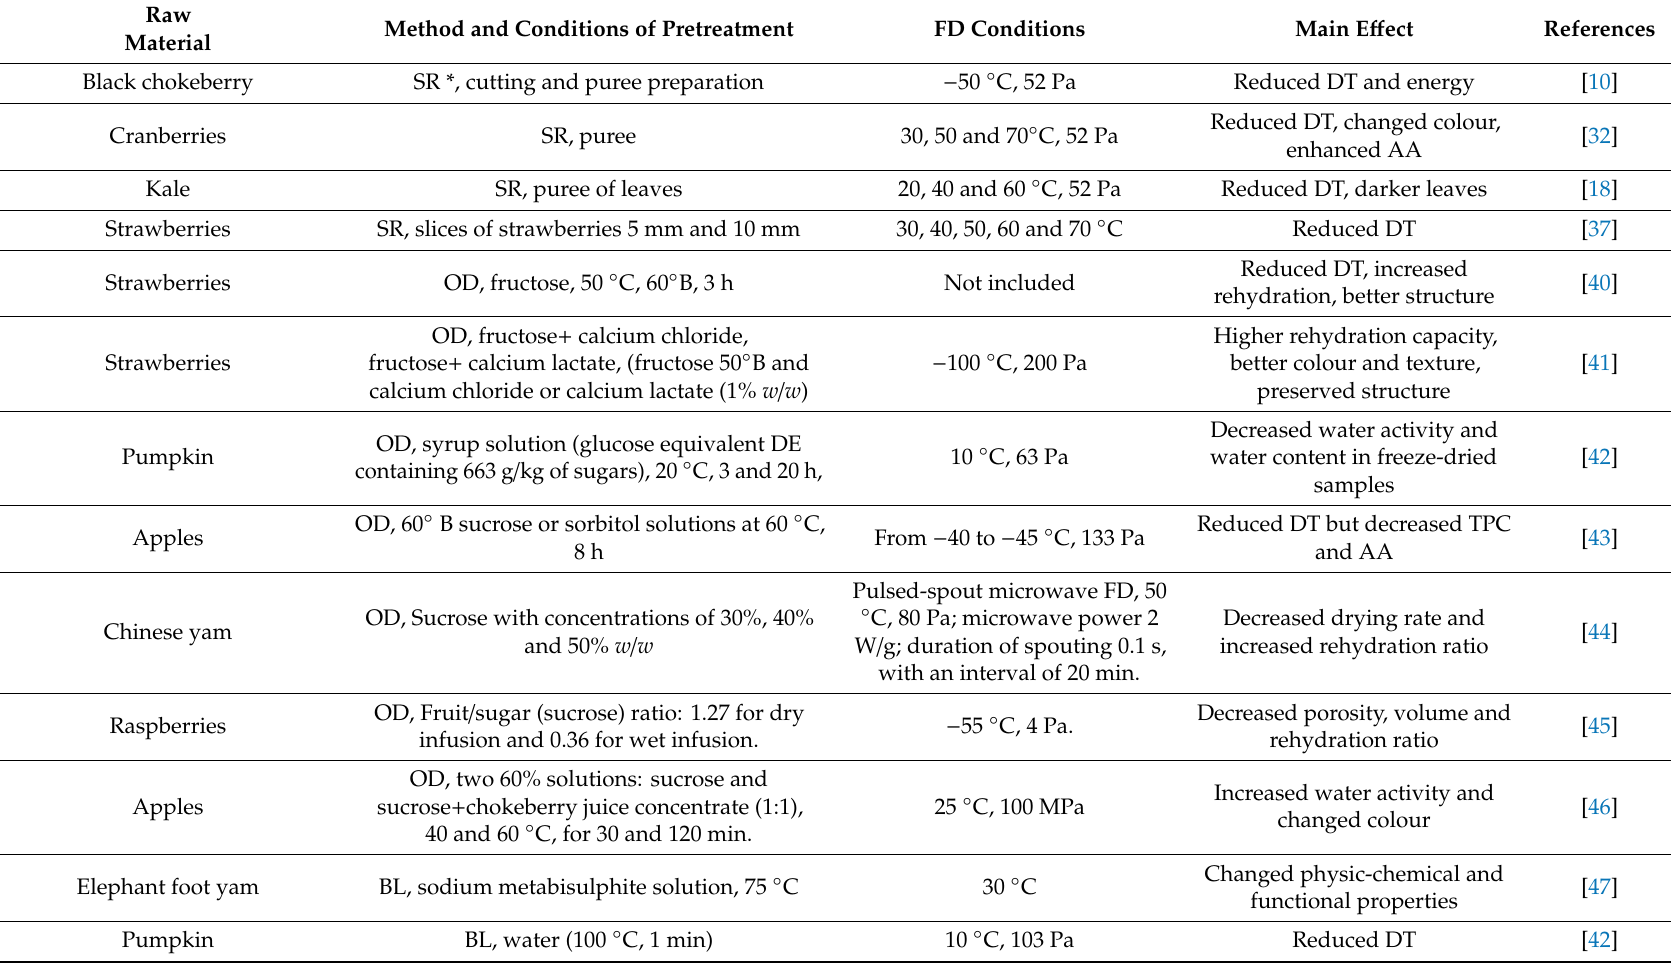
Table 1. Methods of pretreatment of food before FD, drying conditions and e ff ect of